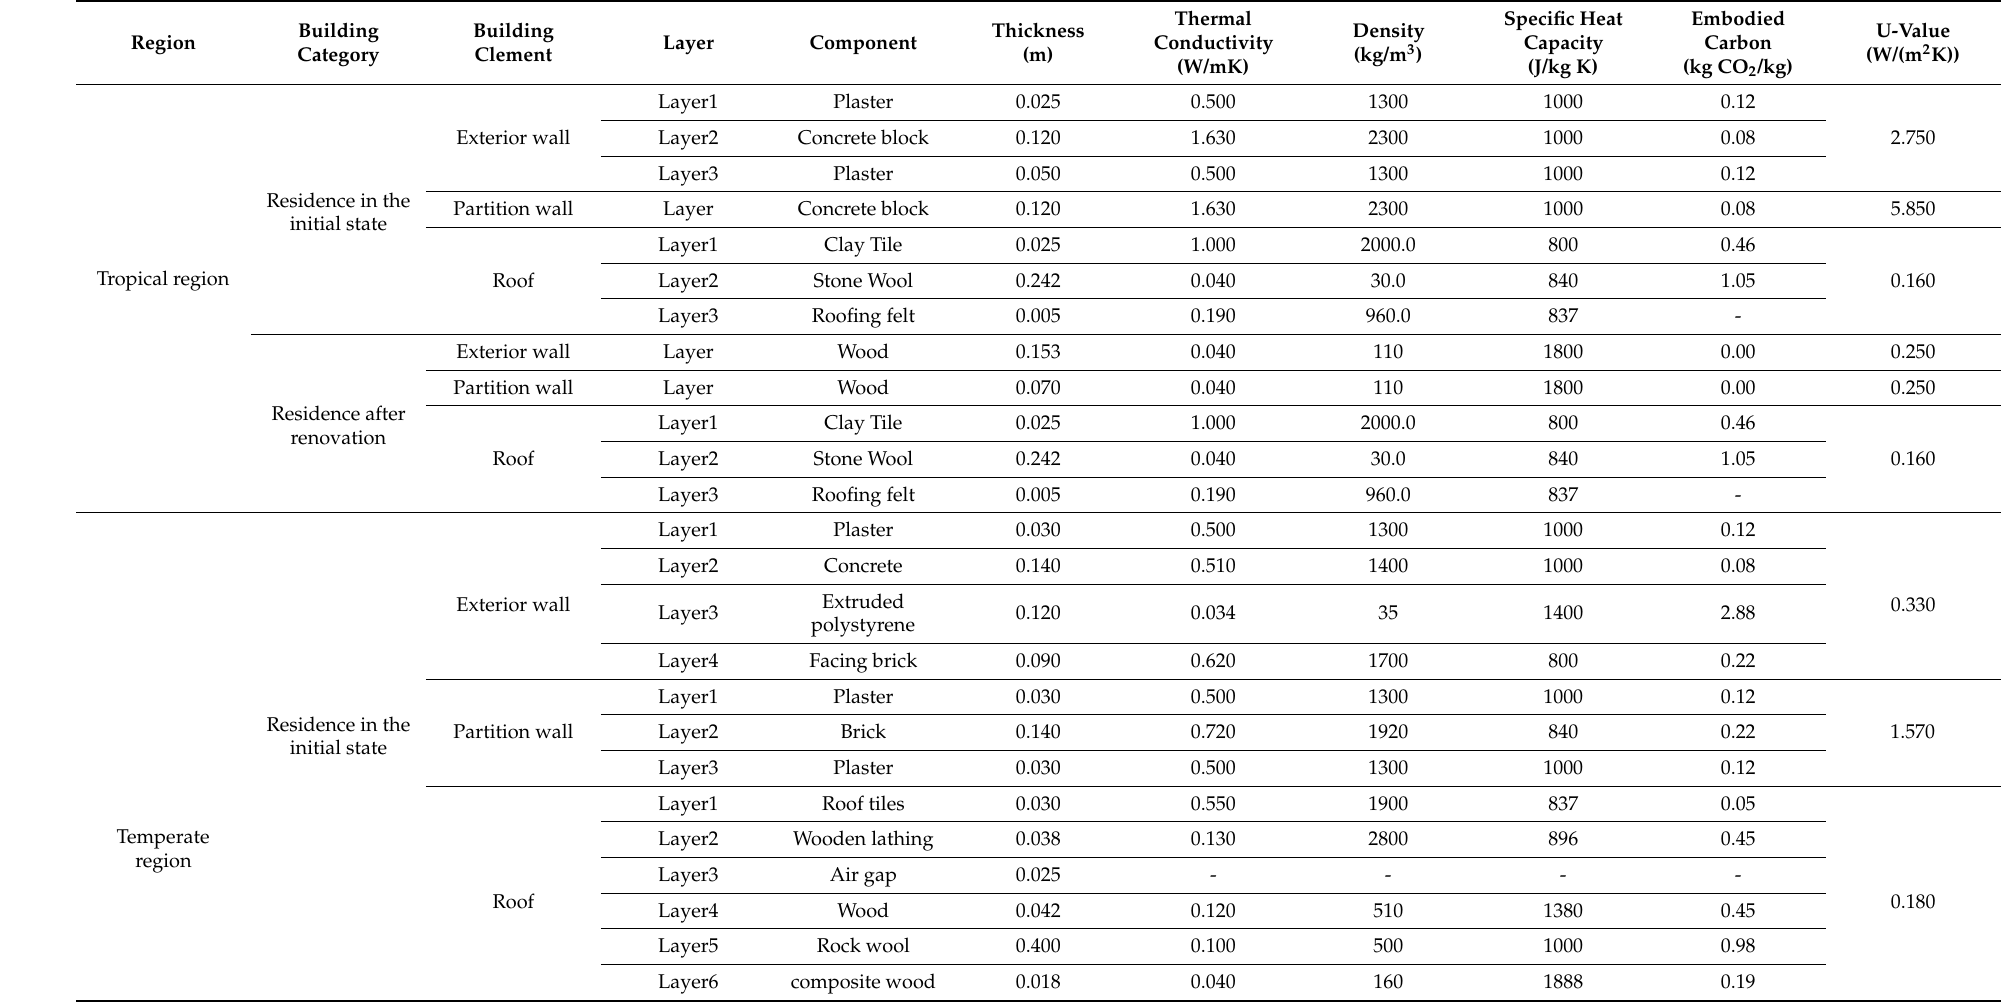
Table 4. Thermal characteristics of building